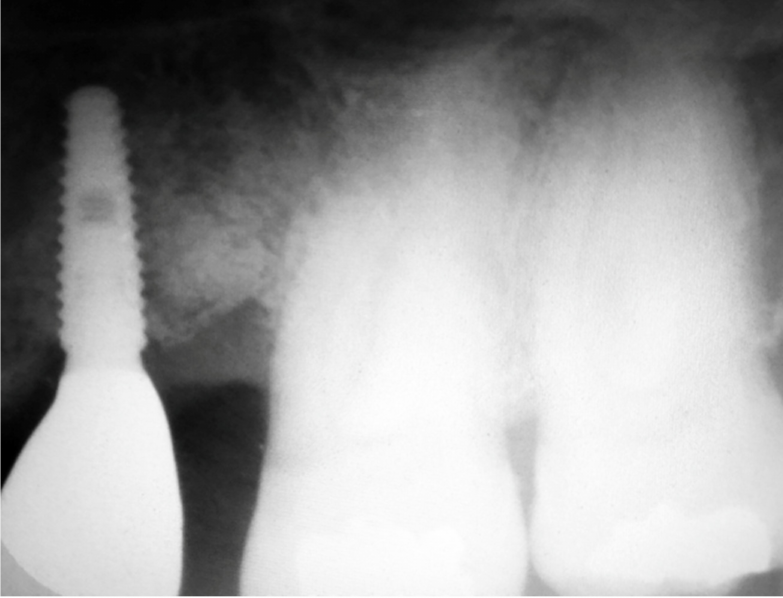
Figure 4. Rx taken at a 5 year follow-up showing the stability of the regeneration on both implant and tooth side.